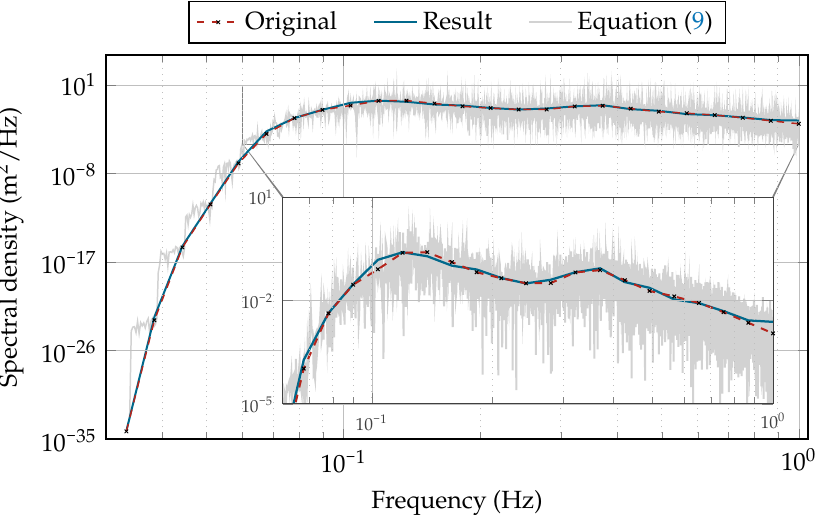
Figure 4. Wave spectra at the point selected for analysis. “Original” is the original spectrum used for the analysis, “Equation (9)” is the result of Equation (9) applied on the time series of η obtained from the original spectrum, and “Result” is the result of Equation (9) after noise removal